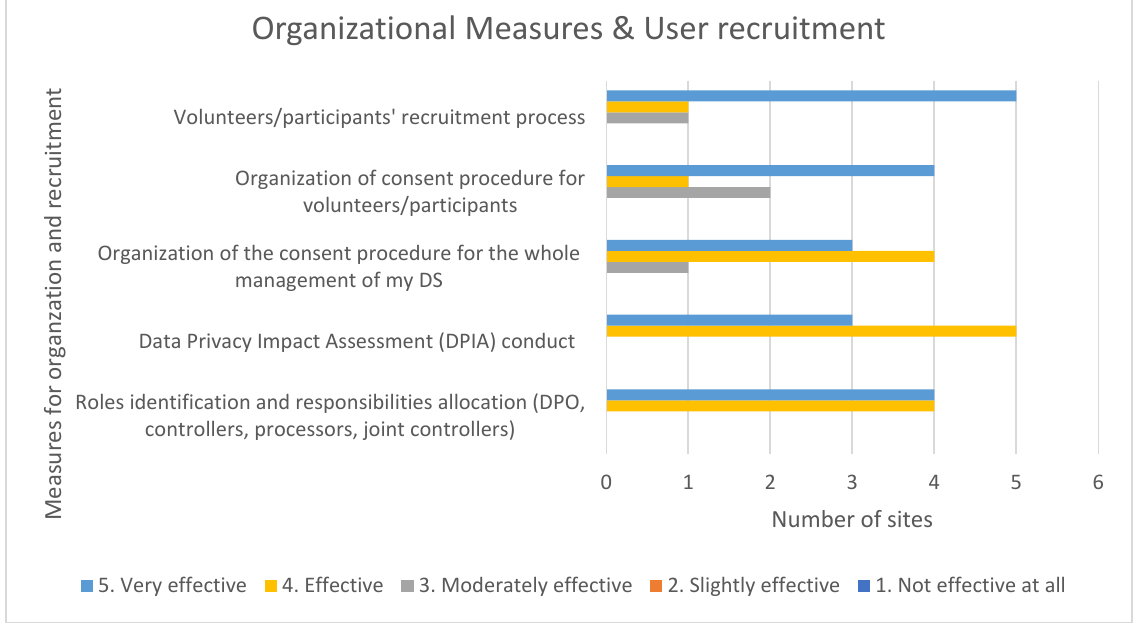
Figure 6. Organizational measures and user recruitment.